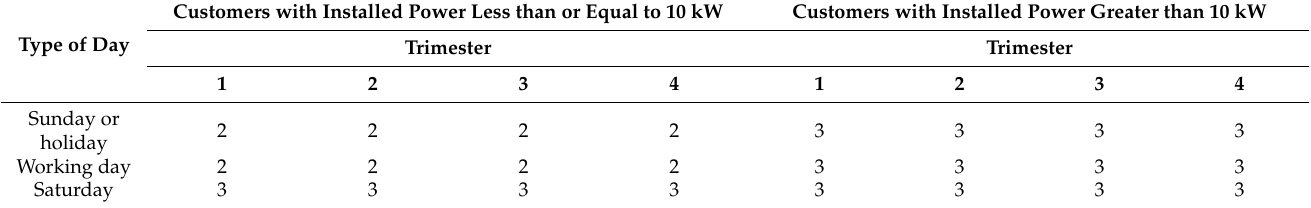
Table 4. Optimal number of groups (k) for typical days per quarter, in commercial